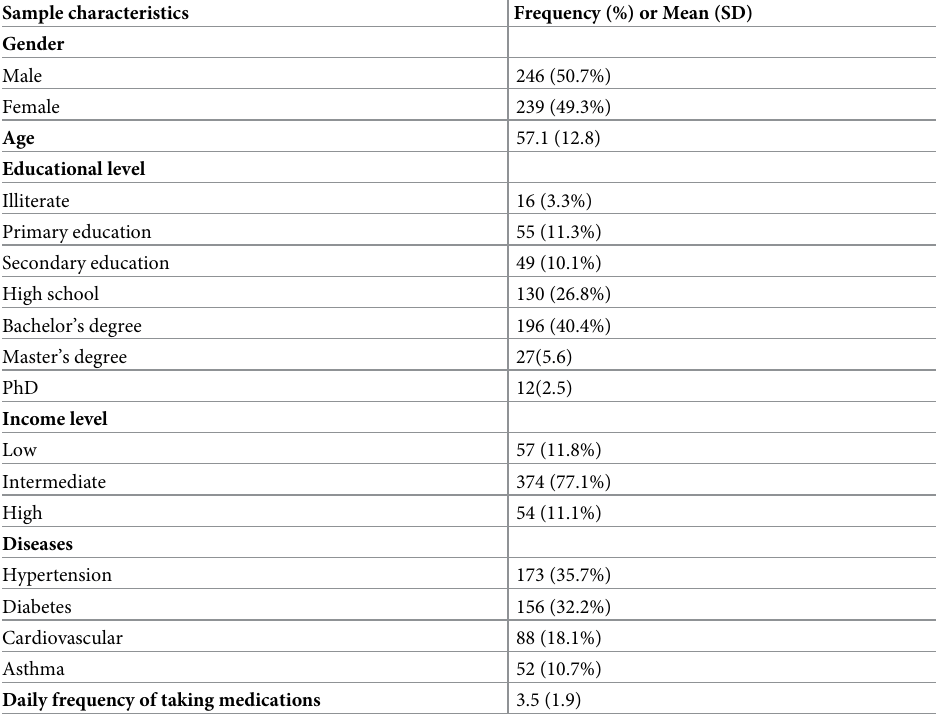
Table 1. Demographic characteristics of the